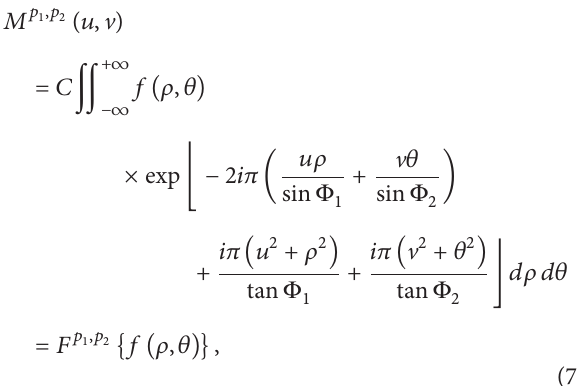
where B 1 = 𝑝 1 𝜋/2 and B 2 = 𝑝 2 𝜋/2 . When the image is trans- formed to an annular domain by log-polar transformation, its FrMT of order (𝑝 1 , 𝑝 2 ) can be written [28]